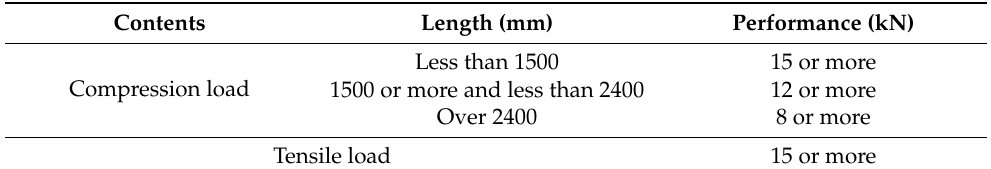
Table 3. Test performance standard for the bracing members of the prefabricated shoring system in Korea